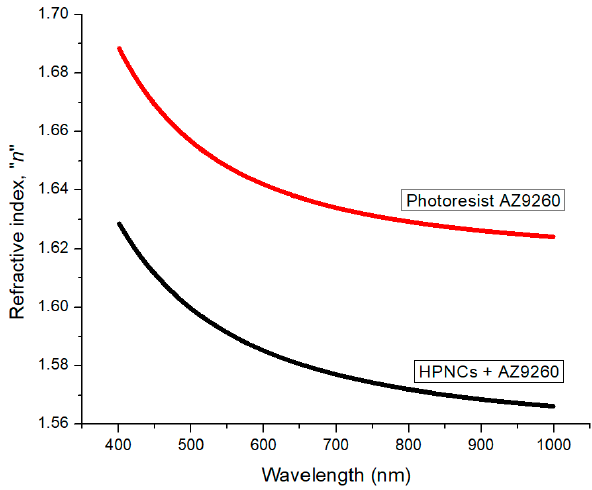
Figure 10. Refractive indices of the photoresist AZ9260 and the HPNCs-dispersed photoresist AZ9260. Table 2. Comparison of refractive indices at specific wavelengths.